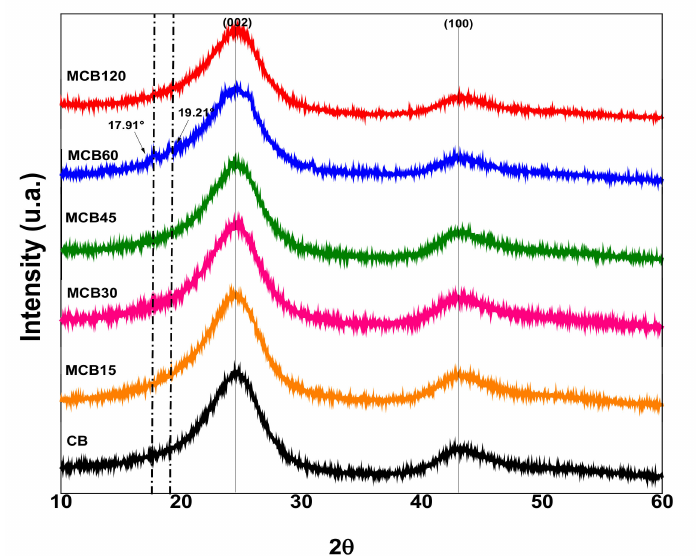
Figure 3. X-ray di ff raction patterns of the unmodified carbon black and the modified carbon black with citric